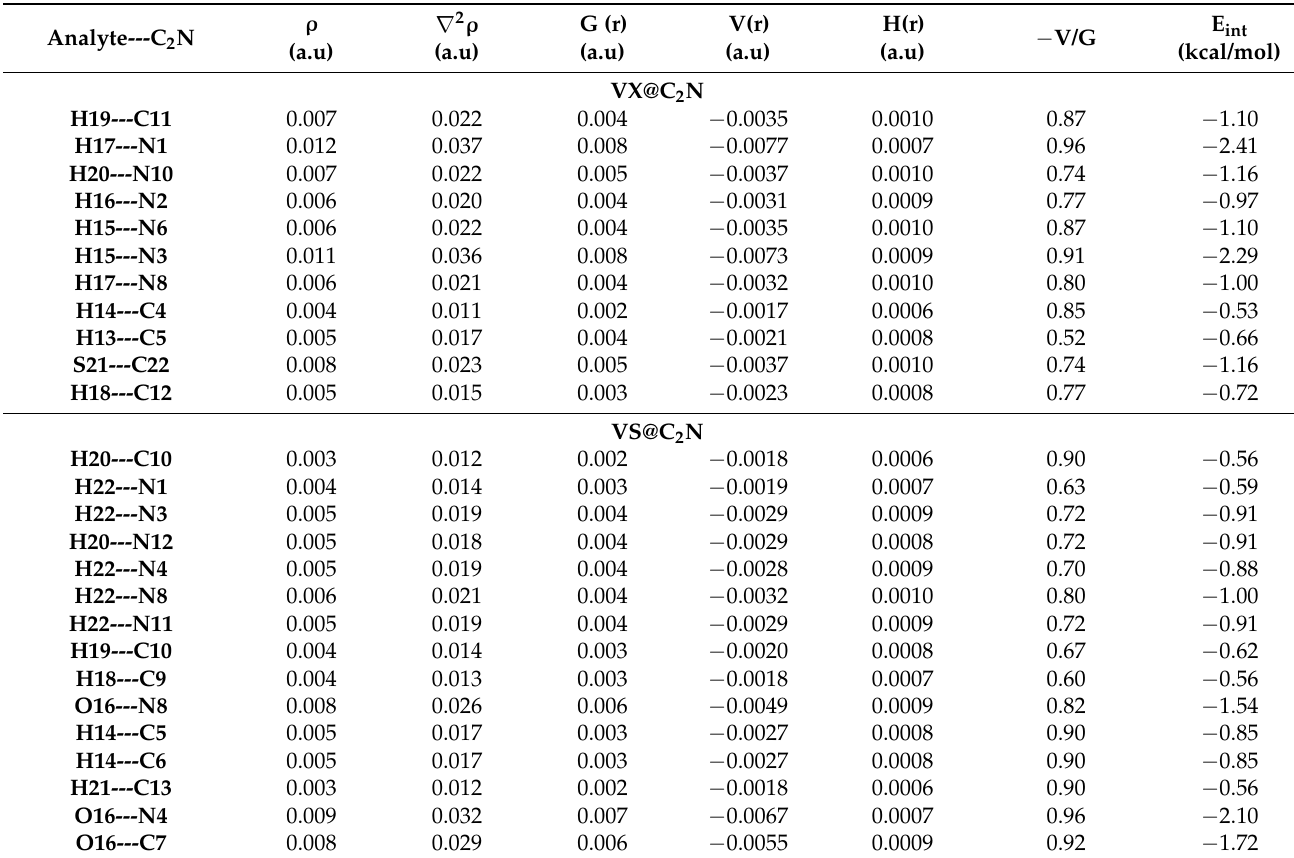
Table 2. Topological parameters obtained through QTAIM analysis for studied V-series@C 2 N